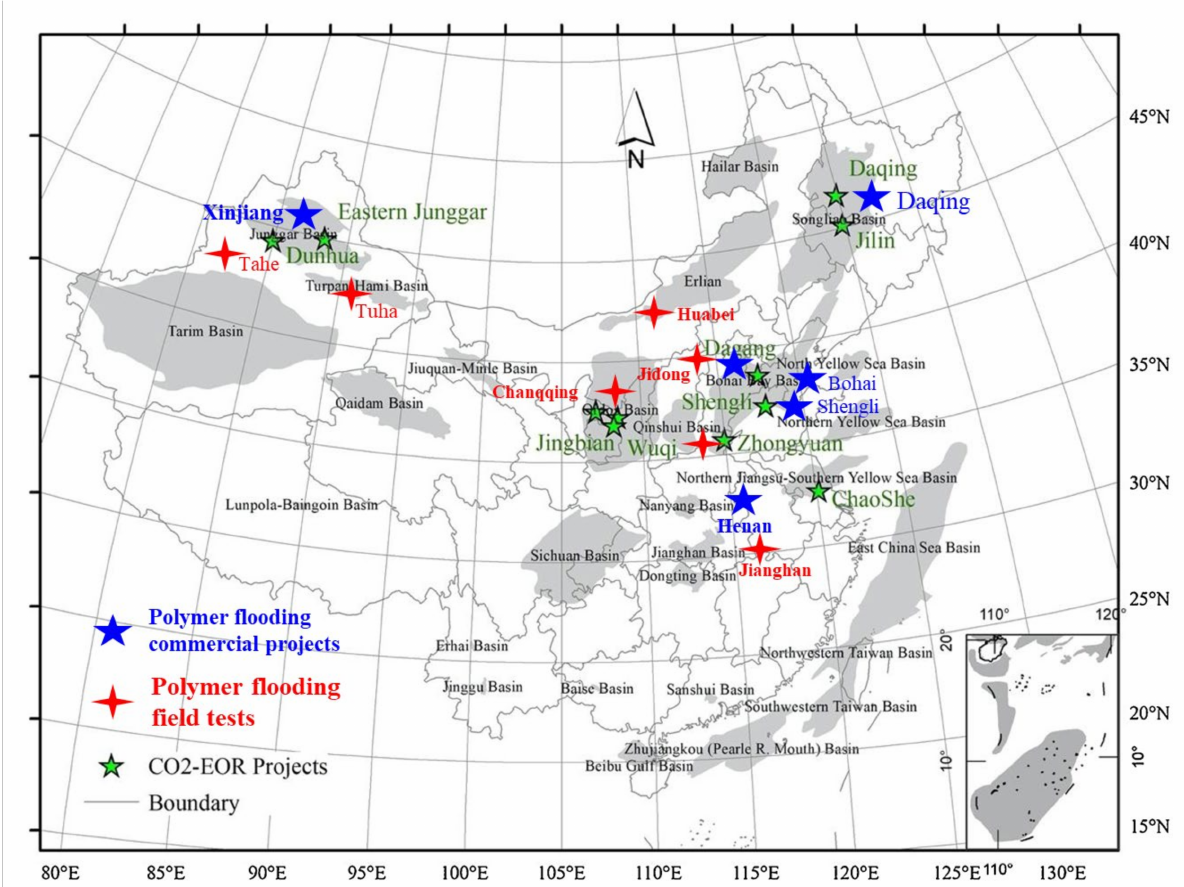
Figure 1. Polymer flooding in China (revised after map from